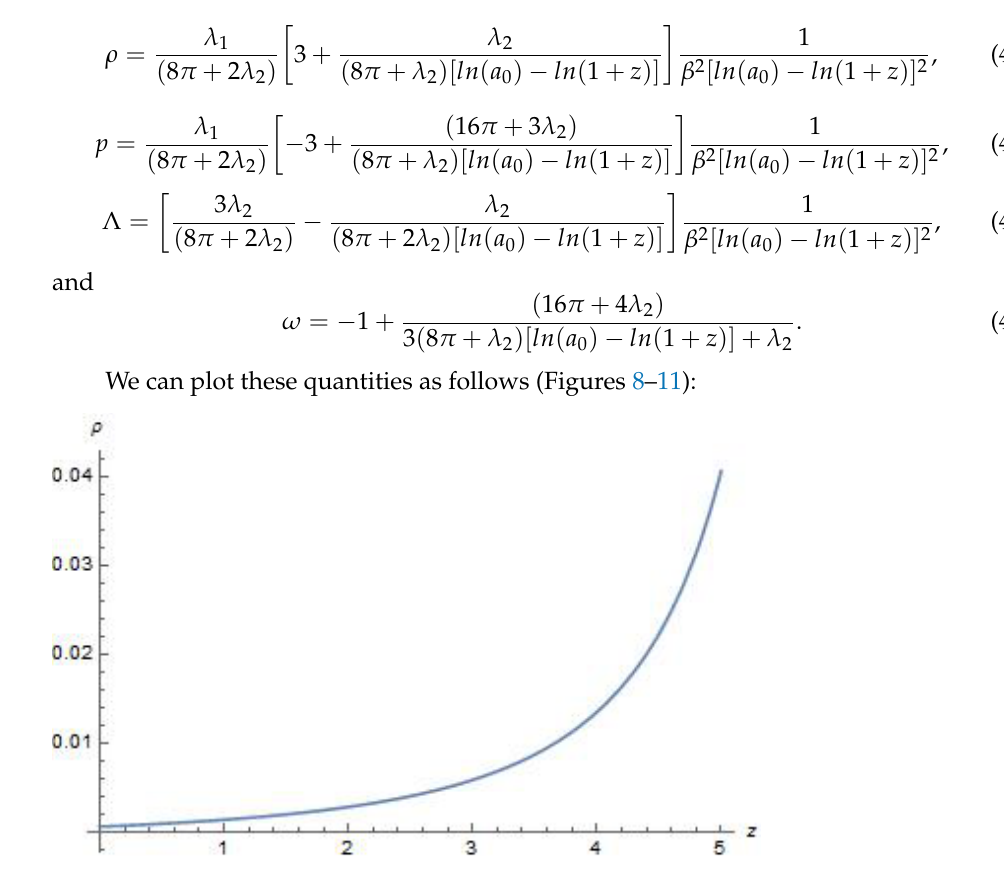
Figure 8. Energy density ρ (in Gyr − 2 ) against redshift z